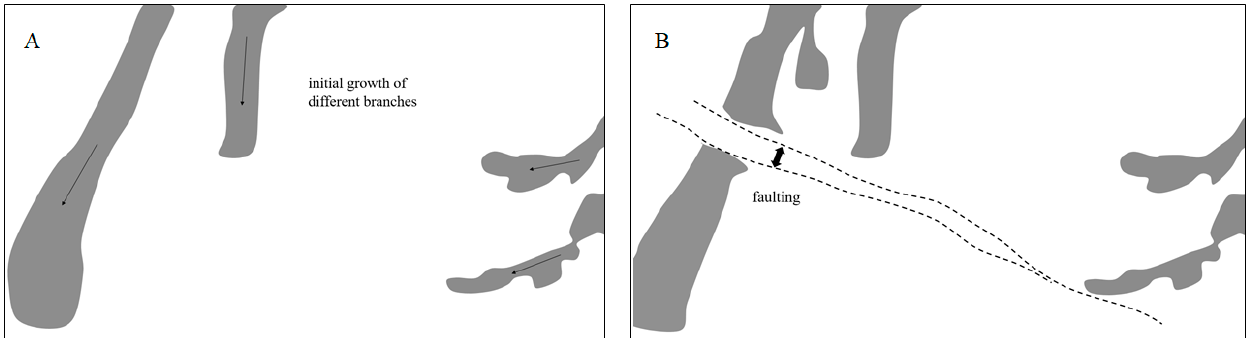
Figure 14. ( A ) Another example of superposing dendritic branches. ( B ) Interpreted order of super- position. The area shown here is marked with a rectangle in Figure 10.